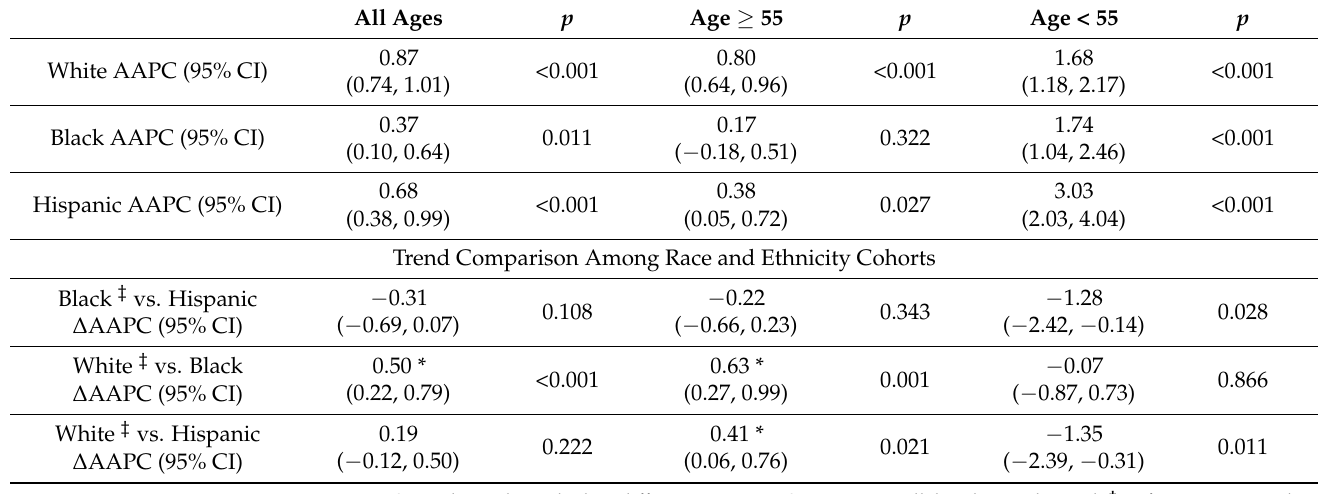
Table 3. Pancreatic cancer incidence time trends for women from 2000 to 2018 stratified by age, race and ethnicity as well as comparison of time trends between White, Black and Hispanic